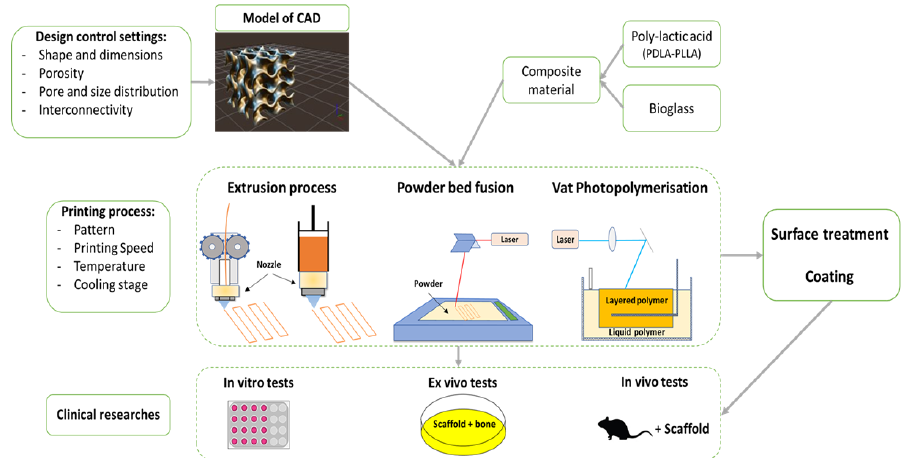
Figure 5. Summary diagram of the different steps in the development of scaffolds as biomaterials.